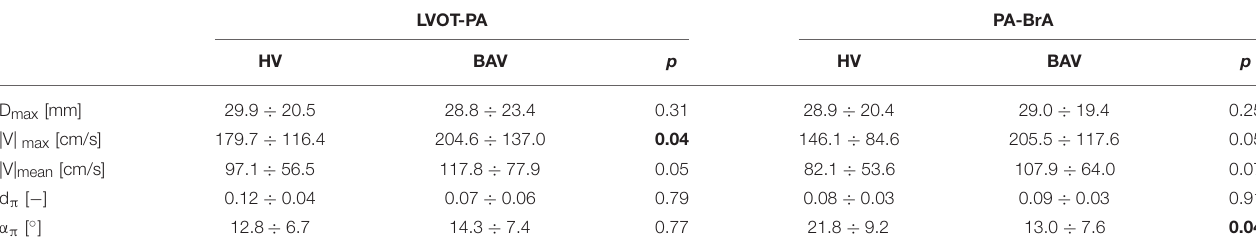
TABLE 3 | Hemodynamic variables computed along the centerline for HV and BAV patients, from LVOT to PA and from PA to BrA landmarks. LVOT-PA PA-BrA